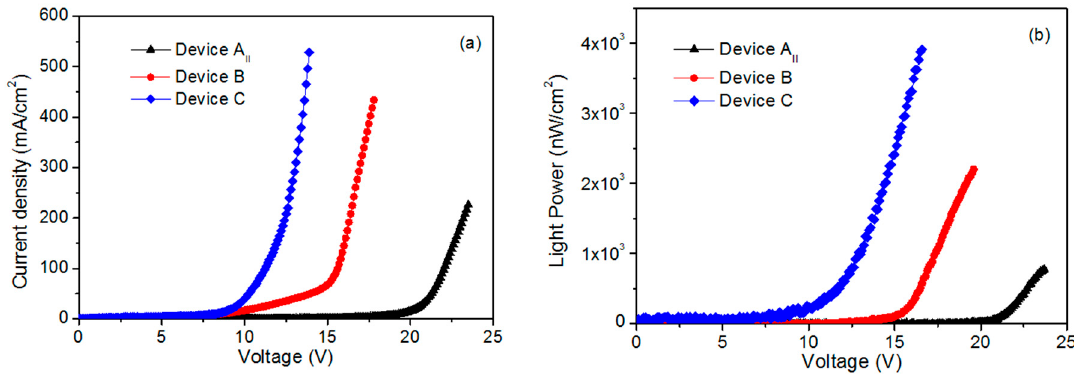
Figure 5. J–V characteristics ( a ) and L–V characteristics ( b ) of the three devices.